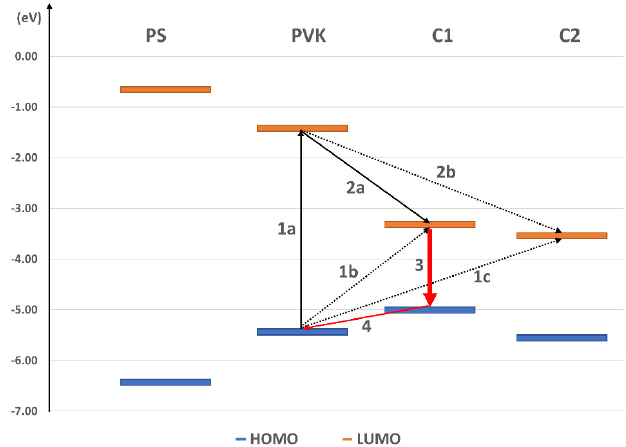
Figure 3. Energies of orbital levels of PS, PVK, C1, and C2. The arrows indicate possible electronic transitions.